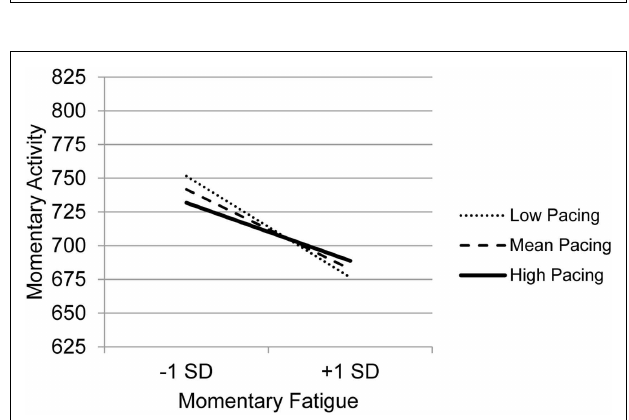
FIGURE 3 | Simple regression slopes for centered momentary fatigue and use of Resting at low, mean, and high levels of momentary physical activity.